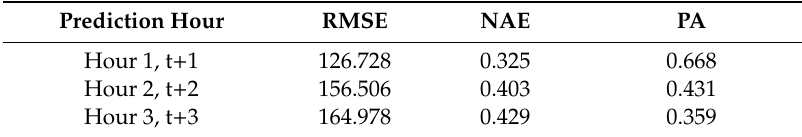
Table 5. Summary of performance indicator for all PM 10 forecasting models during the transboundary haze